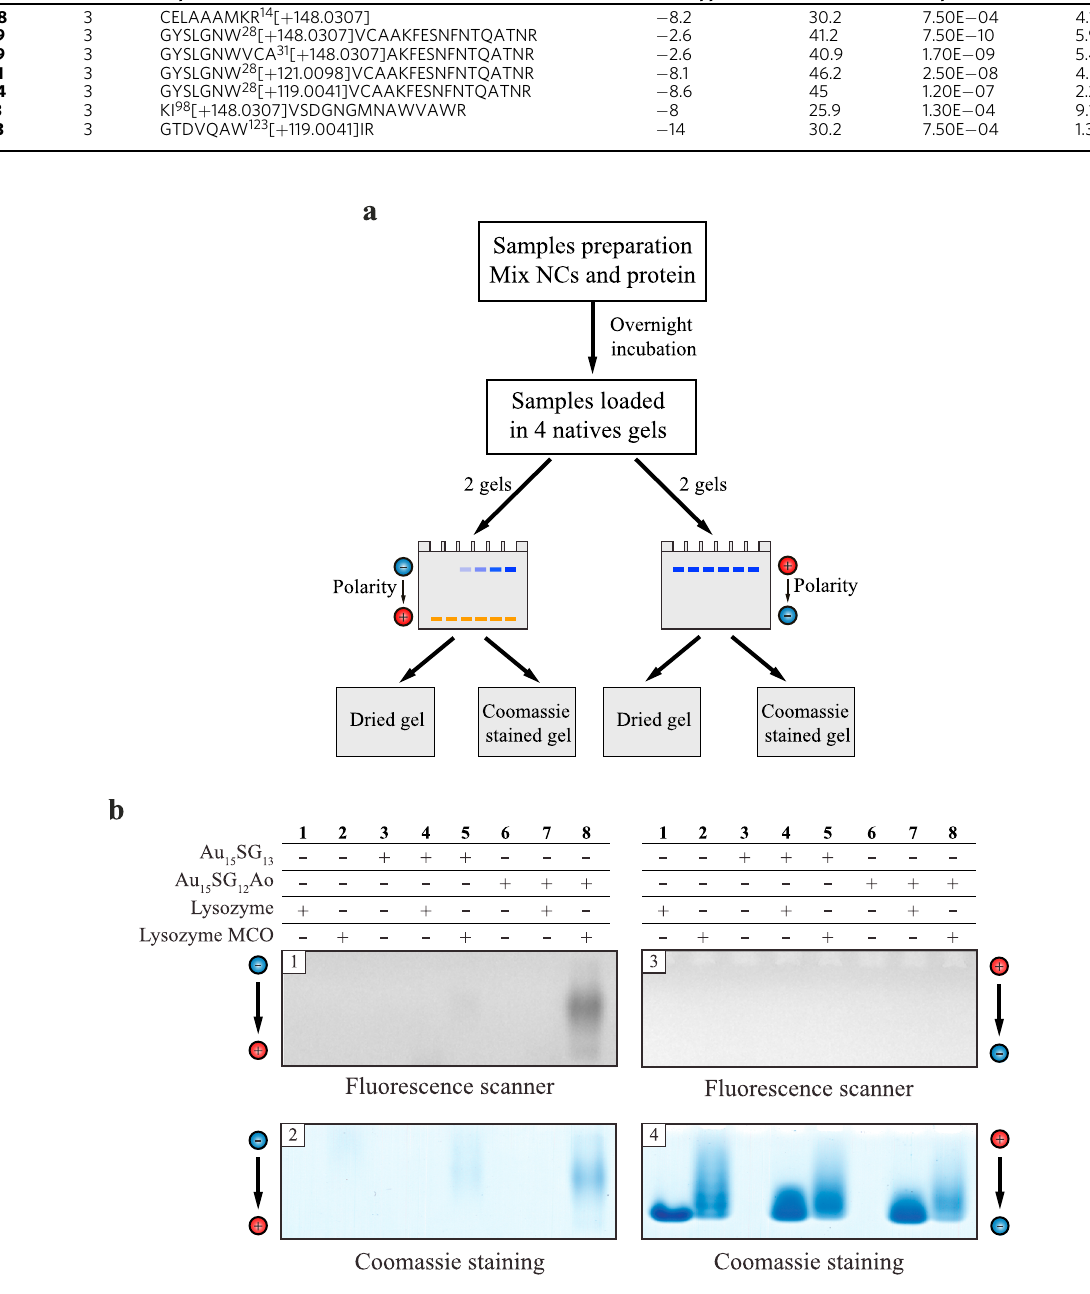
Fig. 3 Au 15 SG 12 -Ao can detect carbonylated proteins in polyacrylamide gels. a Schematic representation of the experimental setup for NCs migration in gels. b Four identical sets of samples were simultaneously migrated on native polyacrylamide gels with electricity direction from anode to cathode (gels 1 and 2) or from cathode to anode (gels 3 and 4). Gels 1 and 3 were dried and imaged by a fl uorescence imaging scanner. Gels 2 and 4 were stained using Coomassie staining and images were obtained using a gel scanner. The displayed images are representative of three replicates. Source data and replicates for ( b ) are provided in Supplementary Data 1 Figs.